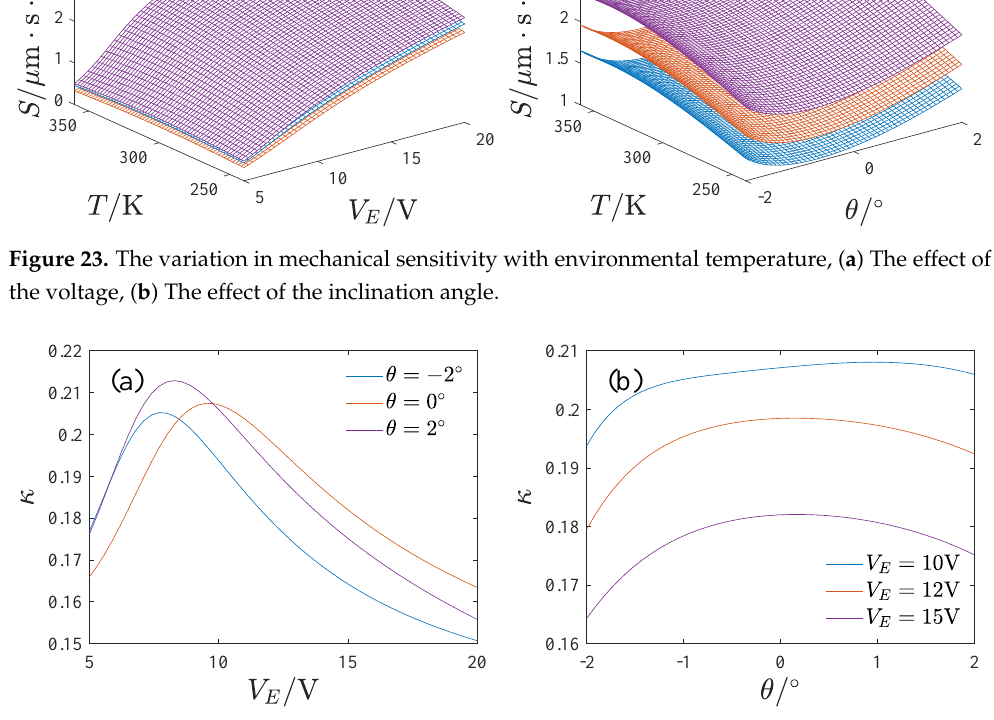
Figure 24. The full temperature stability of the mechanical sensitivity, ( a ) The effect of the voltage, ( b ) The effect of the inclination